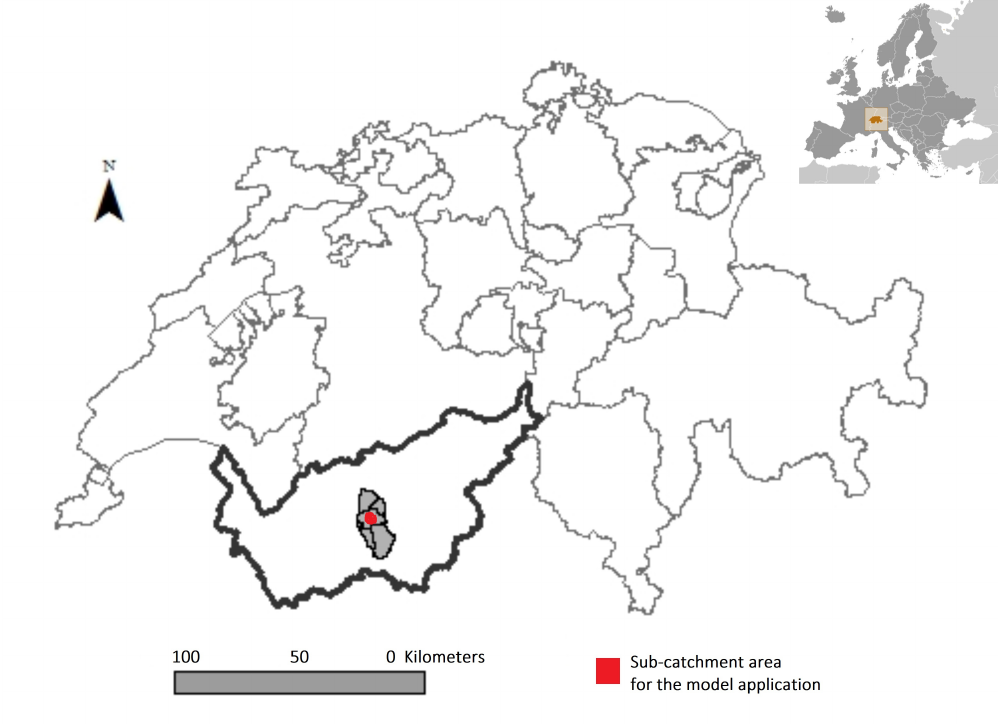
Figure 1. Study case location in Canton Valais,